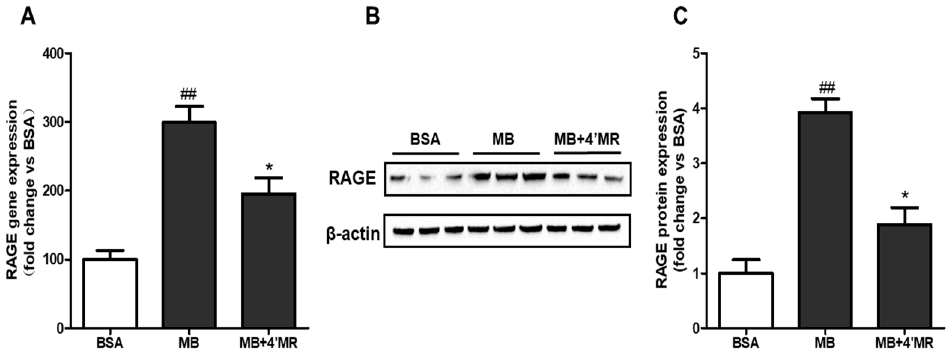
Figure 3. 4 ′ -Methoxyresveratrol inhibited RAGE expression induced by MB in RAW264.7 macrophages: ( A ) RAGE mRNA level was determined by qPCR. Gene expression was normalized to 18S; ( B ) representative Western blotting images of total RAGE protein expression; and ( C ) quantification of fold-change of RAGE protein expression. Cells were treated with 200 µg/mL BSA or MB with or without 10 µM 4 ′ MR for 24 h. All data are averages of triplicates from three separate experiments. ## p < 0.01 vs. BSA; * p < 0.05 vs. MB. 4 ′ MR, 4 ′ -Methoxyresveratrol.